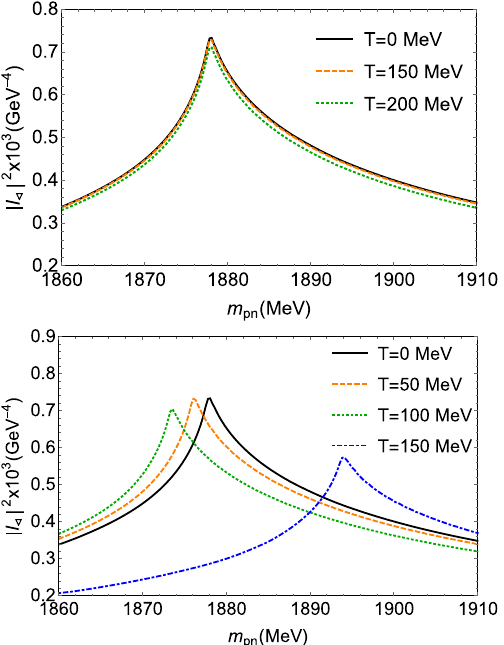
Fig. 6 The triangle diagram that would appear in the ππ spectrum from X → 3 π decays is not very much affected by temperature (top), evenatalarge500MeVtemperaturethatofcourseputsthecomputation outside the realm of hadrons and into the qgp, requiring other treatment (but it is shown for illustration). However, if thermally modified masses and widths are included, the singularity is quickly washed away